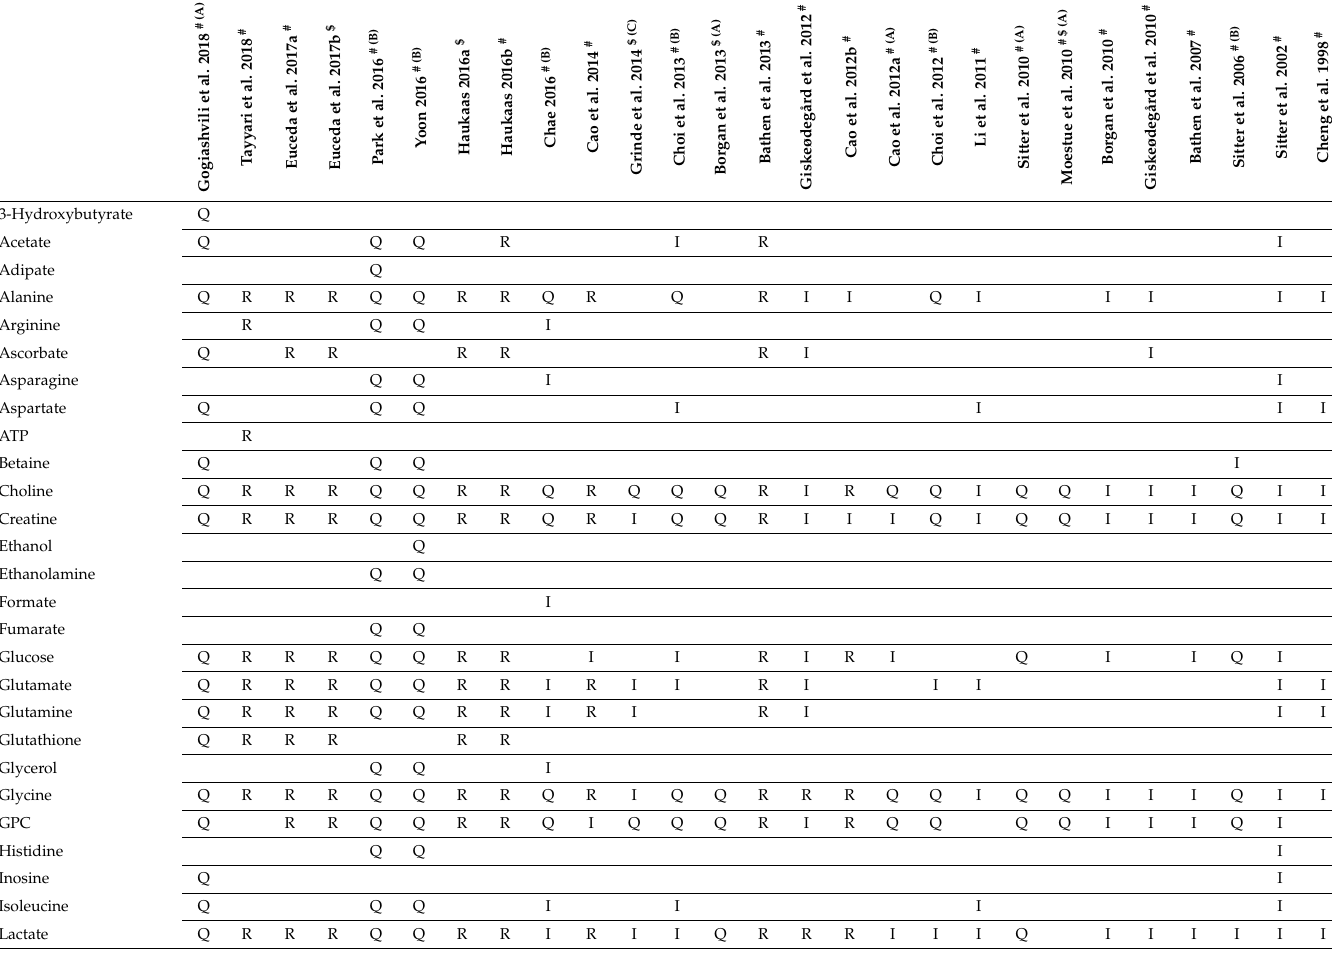
Table 1. Overview of metabolites reported in HR-MAS NMR breast cancer tissue studies. Q: absolute quantification with concentrations given in e.g. µ mol/g tissue; R: relative quantification; I: identified but not quantified; # patient tumour tissue; $ xenograft tissue; (A) ERETIC; (B) TSP; (C)